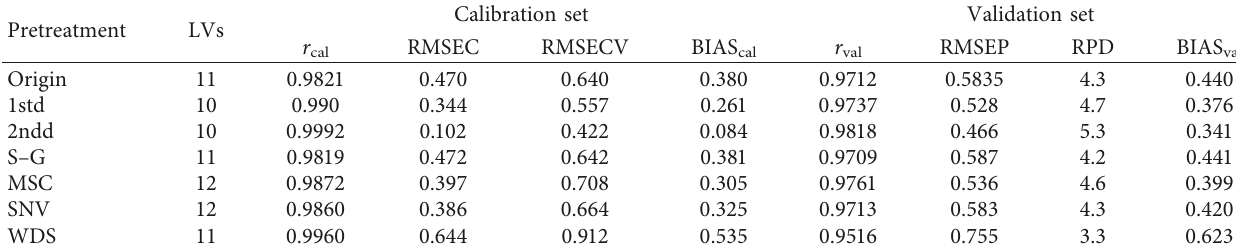
Figure 1: Raw NIR spectra of 103 samples. Table 1: PLS model characteristics for cryptotanshinone .